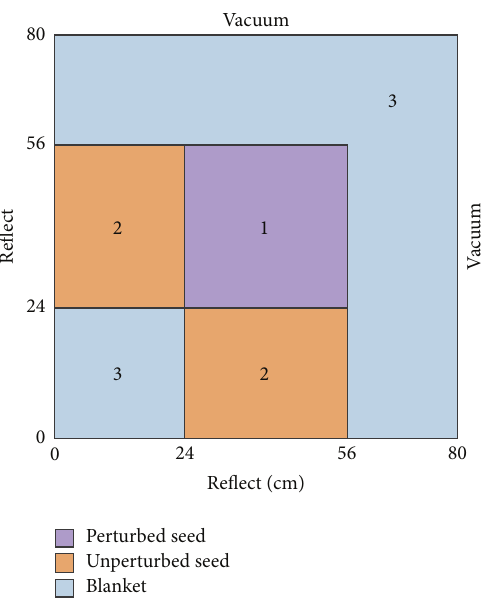
Figure 2: Geometry of the reactor in TWIGL problem.